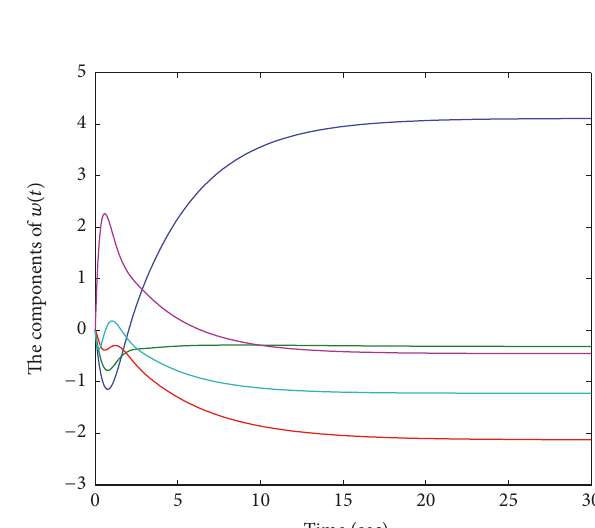
Figure 2: The trajectories of 𝑥 𝑖 .